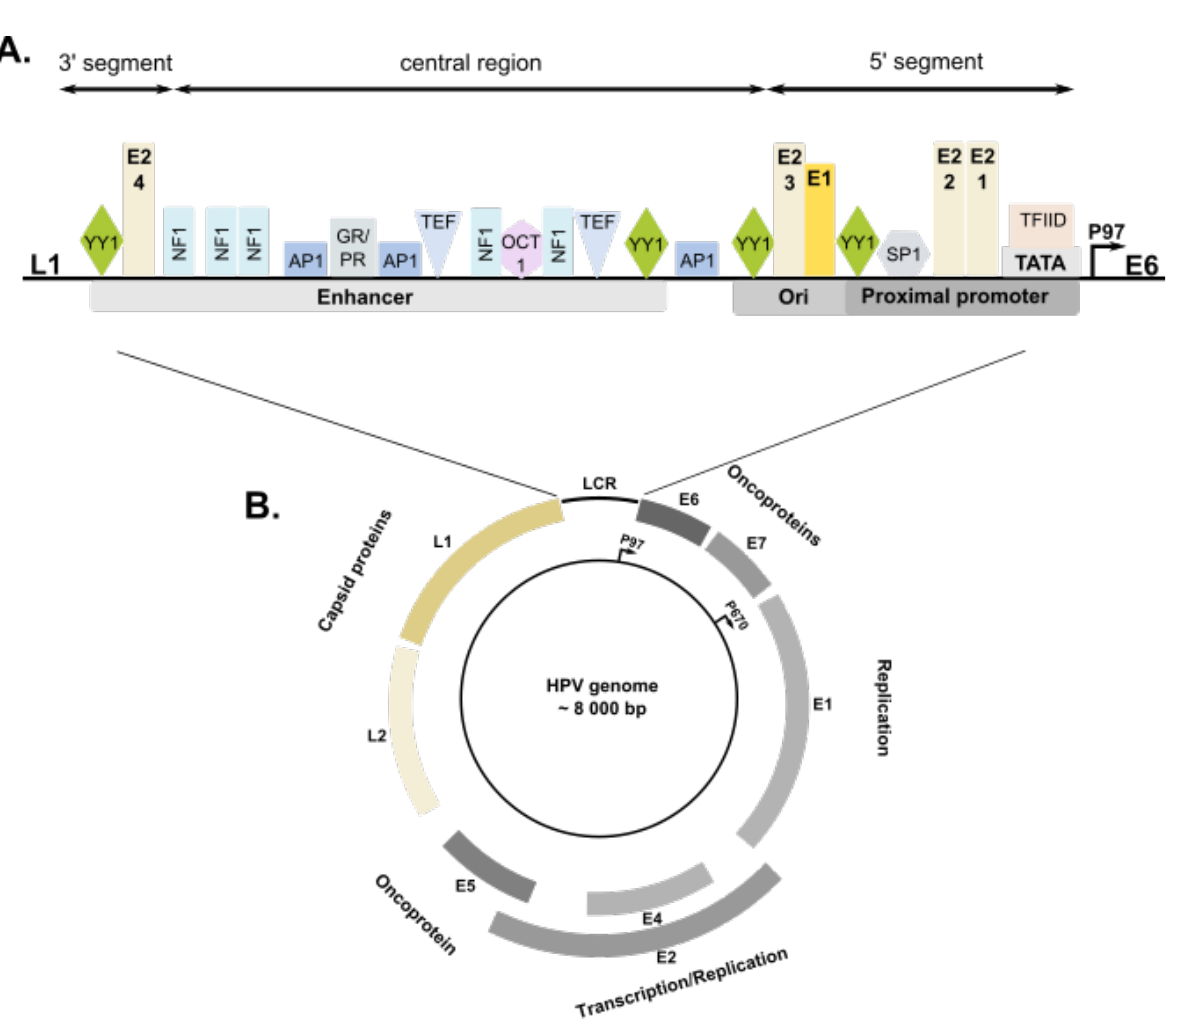
Figure 2. The organization of HPV genome and LCR (long control region) sequence. ( B ) Schematic map of HPV genome. All papillomaviruses have a genome of approximately 8 kb in length, which is divided into three regions. The early region encodes six proteins (E1, E2, E4, E5, E6, and E7), and the late region codes for two structural proteins (L1 and L2). The noncoding LCR contains the major cis-regulatory sequence, which is involved in the initiation and regulation of replication. In addition to this, it controls the expression of E6 and E7 oncogenes. The early (P97) and late (P670) promoters are marked by arrows. ( A ) Representative structure of LCR (region of control of early promoter P97). The fragment of the LCR sequence (central region and 3’ segment) was enlarged to allow visualization of the E1- and E2-binding sites, the TATA element of the P97 promoter, and the binding sites of most important transcription factors, such as AP-1, GR/PR (glucocorticoid and progesterone receptor), NF-1, SP1, OCT-1, TEF-1, TFIID, and YY1. Note that only a limited number of binding sites are illustrated. There are many known binding sites, but it is not possible to illustrate all the transcription factors and their precise binding